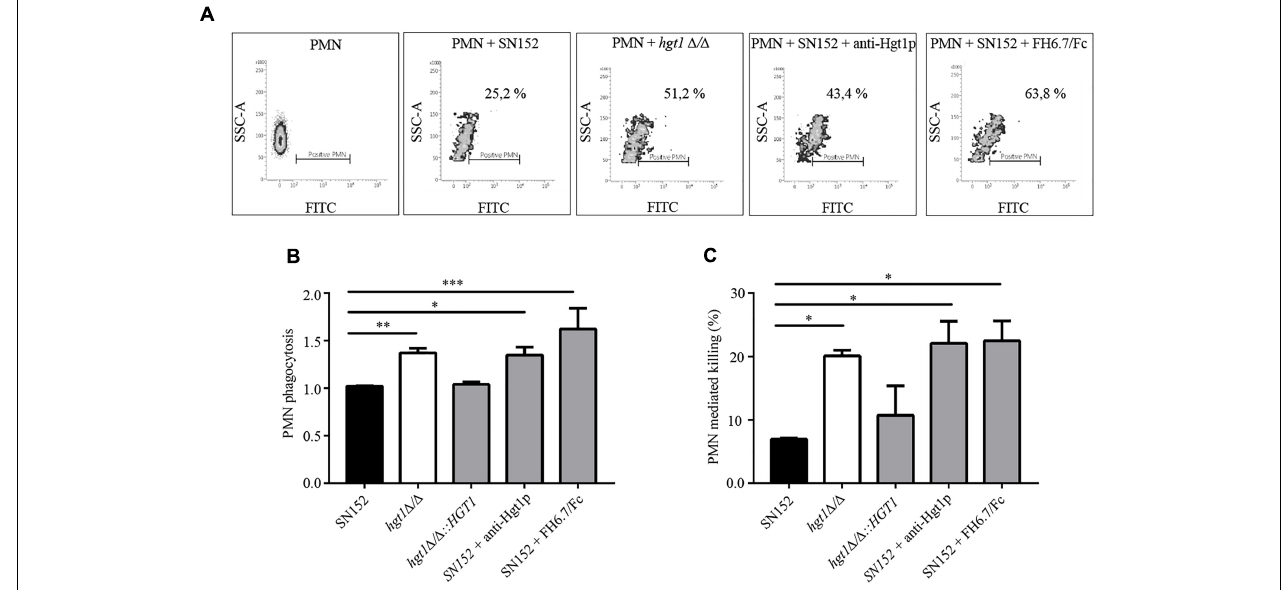
FIGURE 6 | Factor H binding contributes to evasion of phagocytosis by PMNs of C. albicans at physiological glucose concentrations. (A) Scatter (density) plots from a representative experiment showing association of FITC-labeled yeast with PMNs as measured by FACS. The density plots show fluorescence (FITC) on the X-axis as a measure of PMNs with associated C. albicans . The Y-axis shows side scatter. The constituents of each reaction are indicated above each histogram. All reactions contain NHS. (B) Cumulative data to show that loss or decreased FH binding to C. albicans is associated with increased phagocytosis. (C) PMN medicated killing performed under similar conditions as indicated in (B) . Bars represent the normalized mean + SD of four separate experiments. The % of PMNs with associated yeast in (B) is normalized to PMNs co-incubated parental strain SN152 plus NHS. ∗ p < 0.05, ∗∗ p < 0.01, and ∗∗∗ p < 0.001, by one-way ANOVA, using SN152 for comparison.